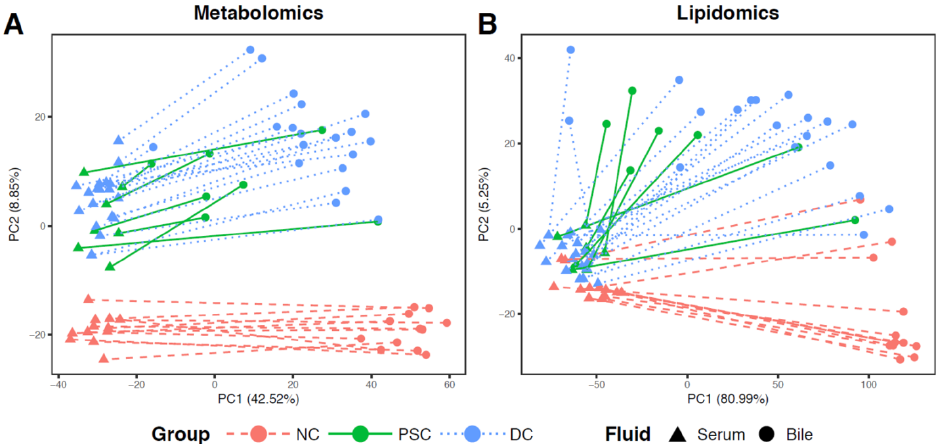
Figure 7. PCA plots of participant-matched portal serum and bile samples based on ( A ) metabolites and ( B ) complex lipids. Serum and bile samples from the same patient are linked with a red dashed line, green solid line, and blue dotted line for NC, PSC, and DC, respectively.